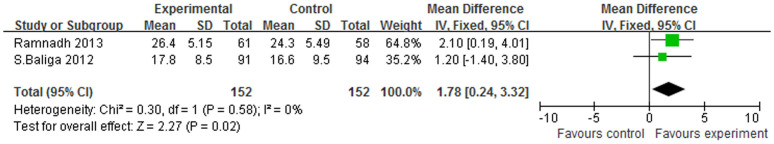
Forest plot of OKS between the circumpatellarelectrocautery and non-electrocautery groups.